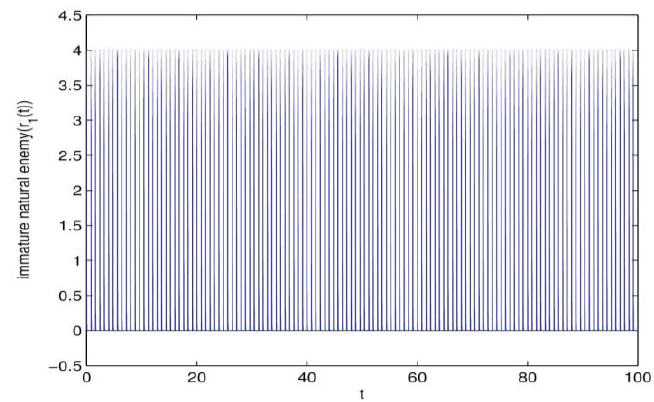
Figure 4. Periodic behaviour of 𝑟